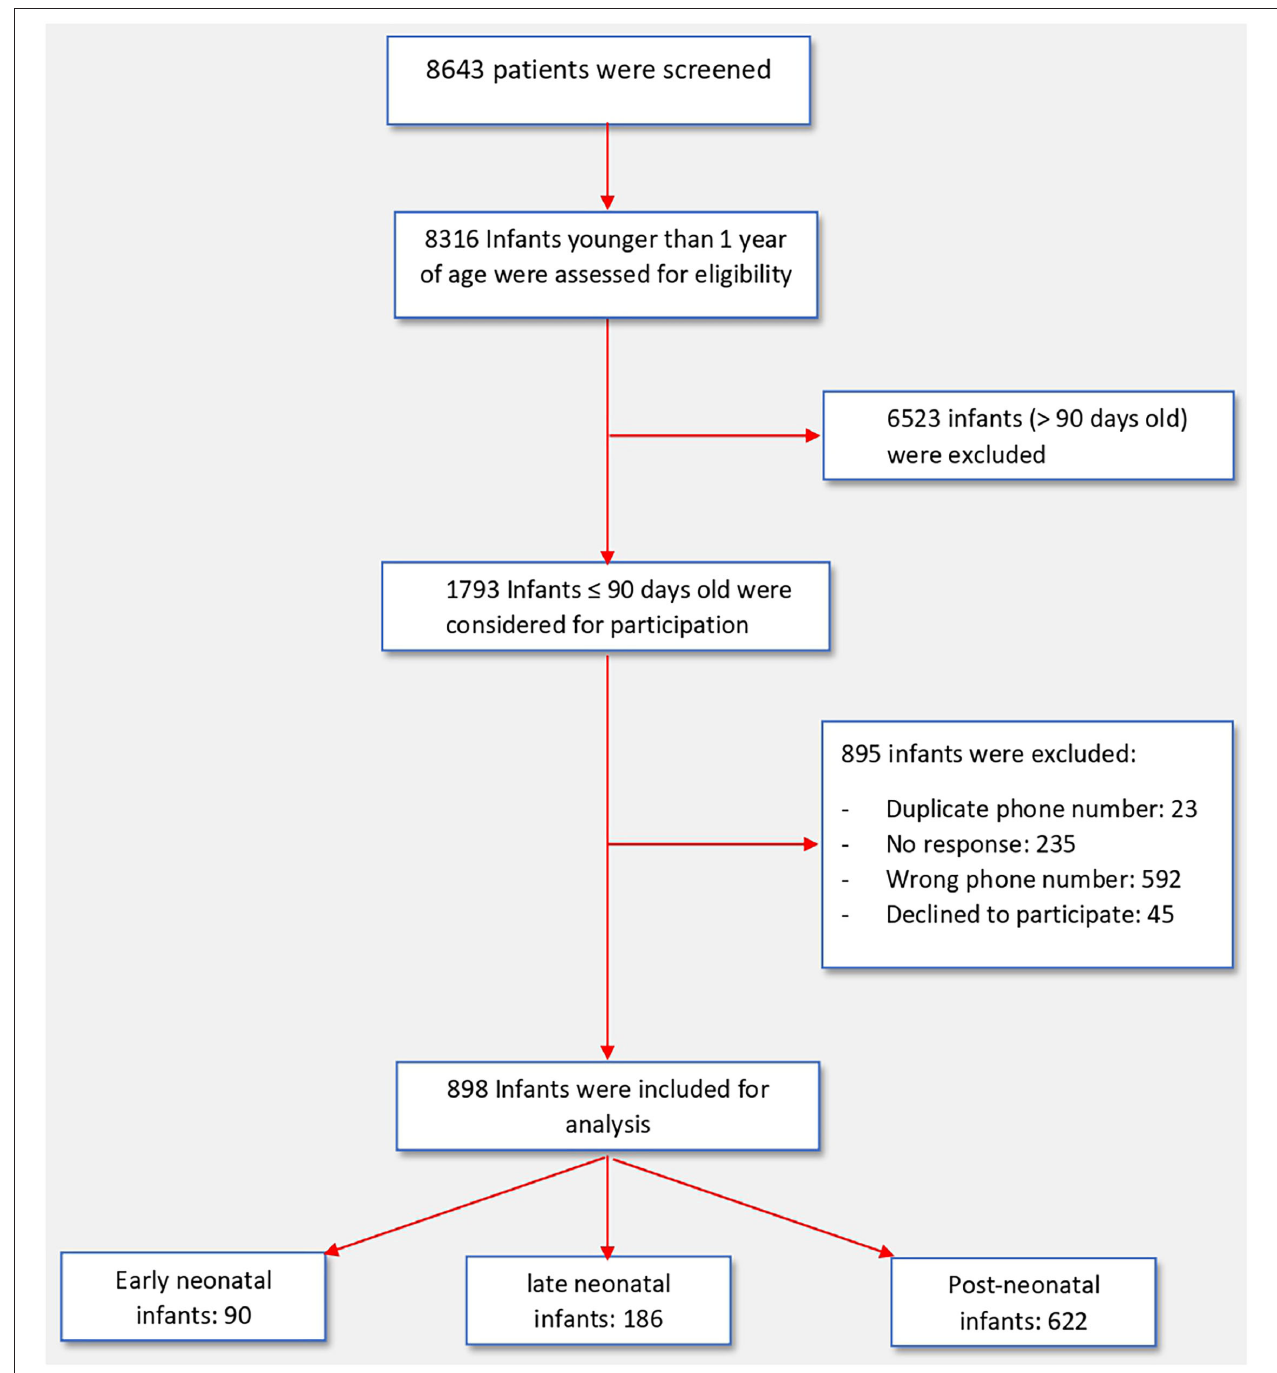
FIGURE 1 | Flow chart showing patient recruitment.